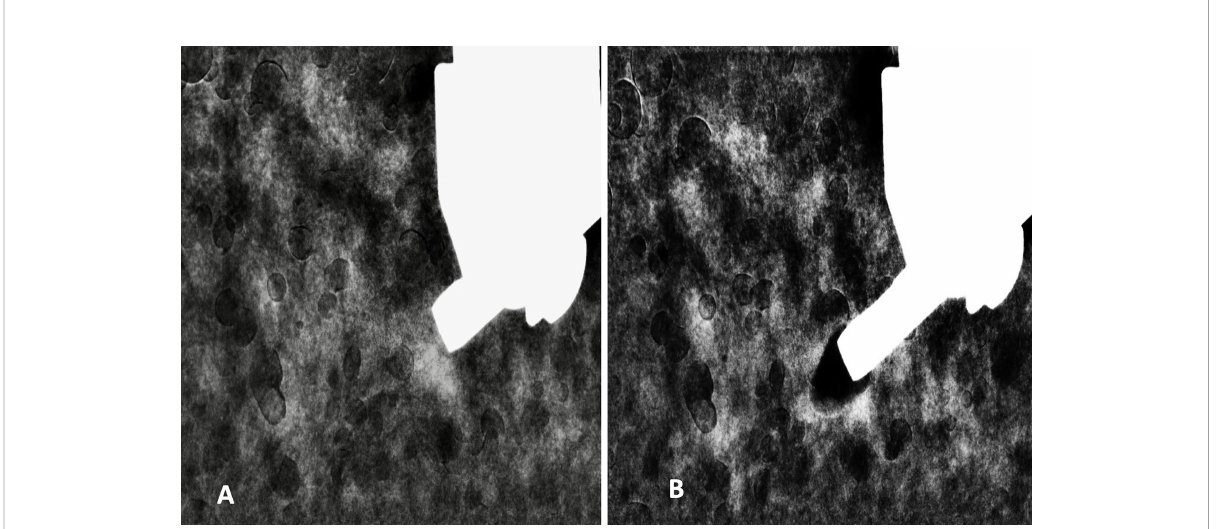
FIGURE 4 REI before (A) and after (B) CESM-Bx demonstrated successful biopsy of the enhanced mass. REI, recombine enhanced image; CESM-Bx, contrast-enhanced spectral mammography-guided